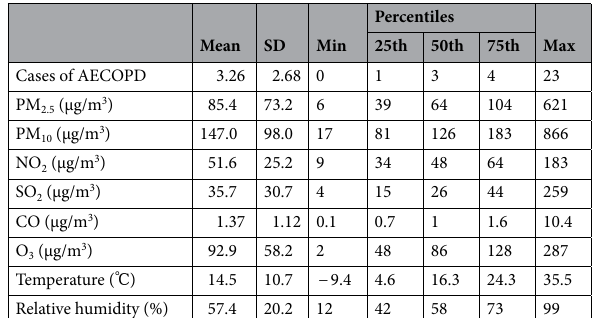
Table 1. Descriptive statistics of the AECOPD cases, air pollutants, and meteorological factors in Shijiazhuang during 2015–2018.